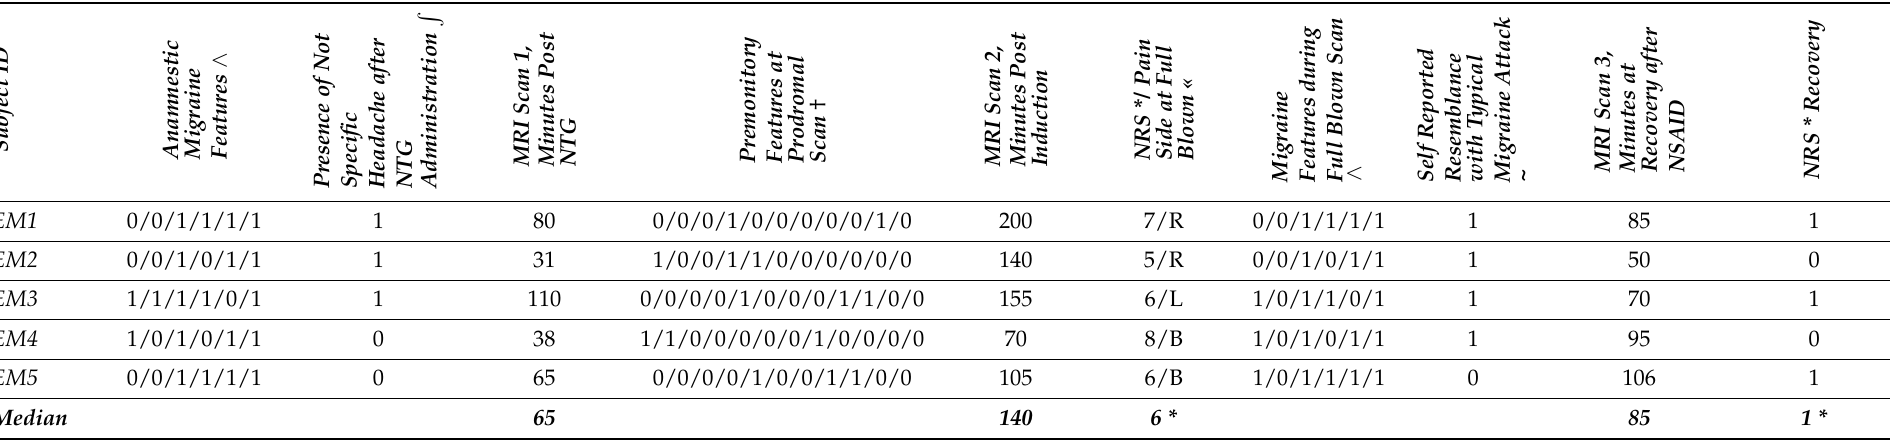
Table 3. Clinical workflow of migraine subjects who developed NTG-induced headache attack and completed the